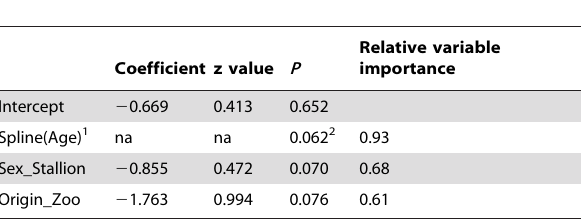
Table 3. Averaged model parameters of a general additive model (GAM) for survival or mortality of 119 Przewalski’s horses that wintered in the eastern part of the Great Gobi B Strictly Protected Area during the dzud winter